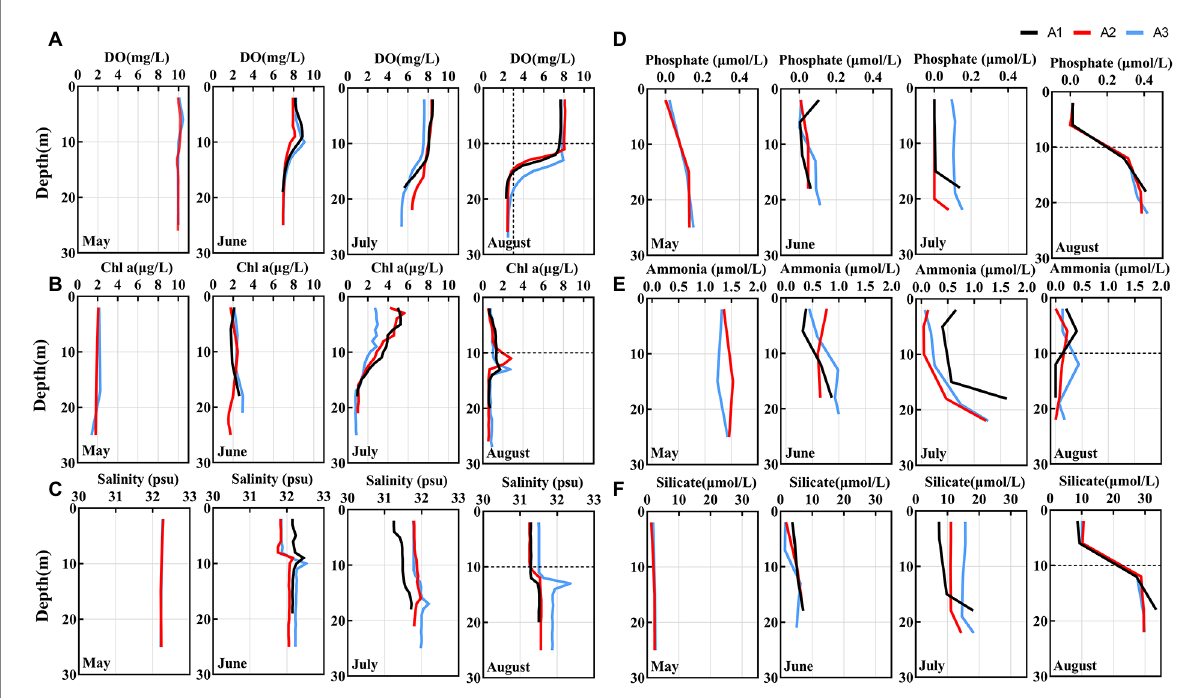
FIGURE 2 (A–C) Depth profiles of hydrological and chemical parameters from May to August in BHS. The hypoxia zone formed in August (The area below the dashed line of Y